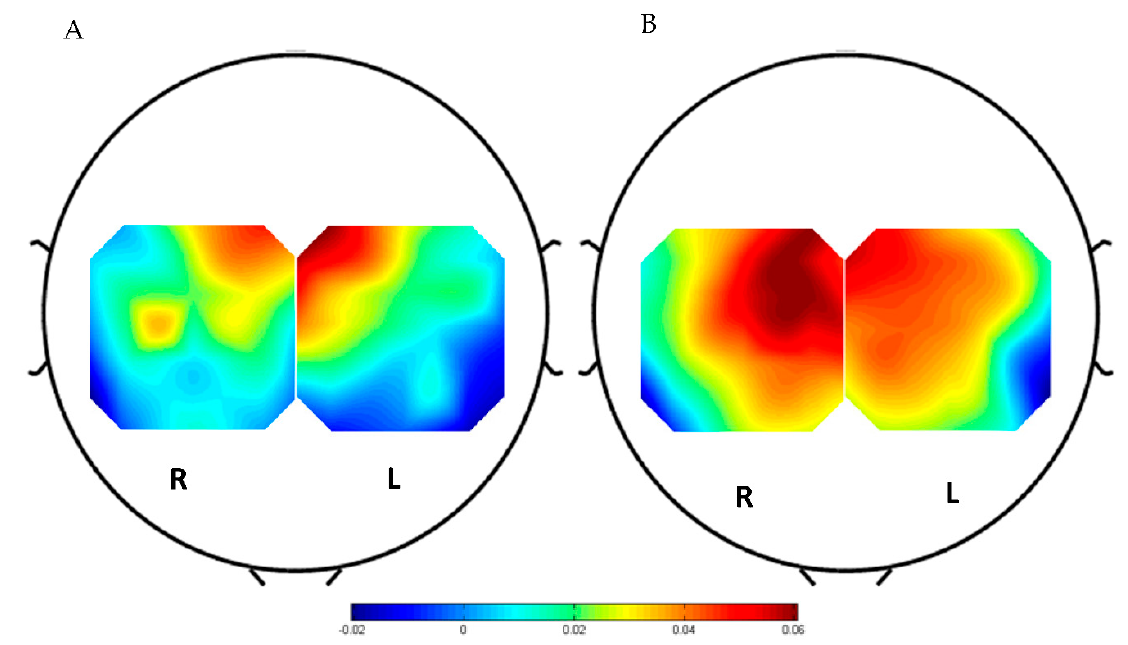
Figure 5. Average topoplot of oxyHb concentration of motor cortex ( A ) during right ankle movement and ( B ) during left ankle movement.